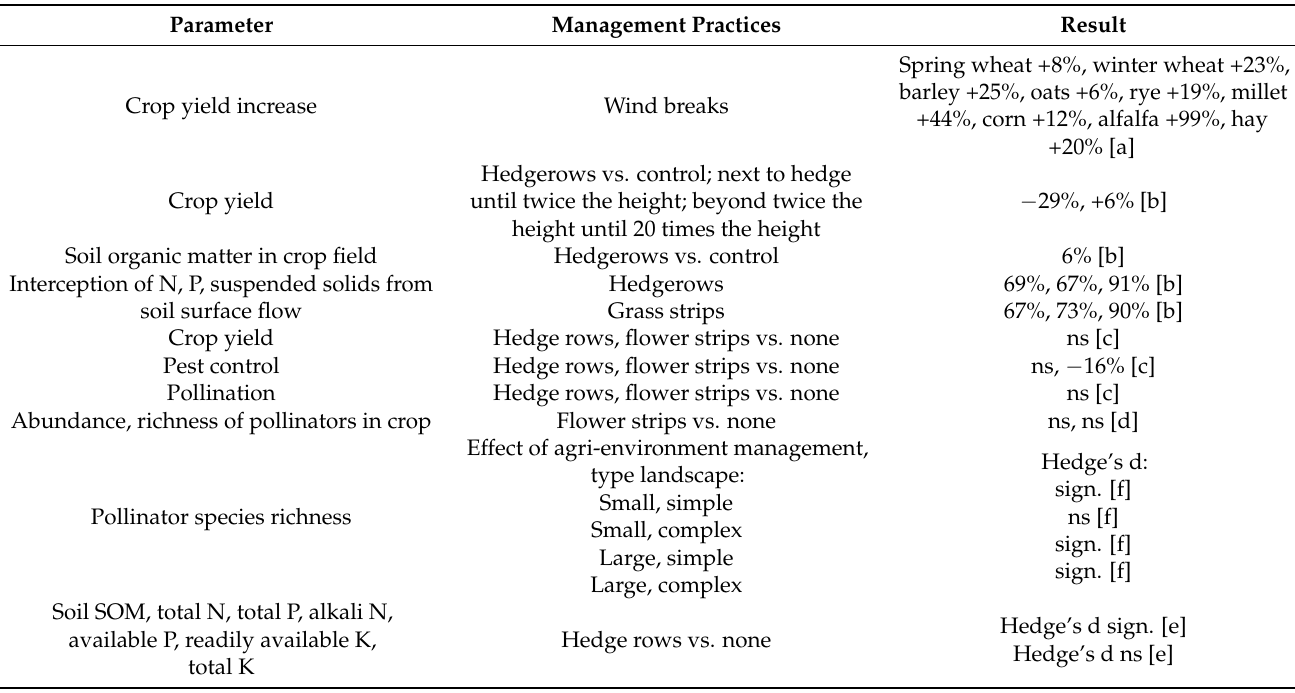
Table 5. Landscape management: summary of the results as reported by meta-analysis studies. See also Table